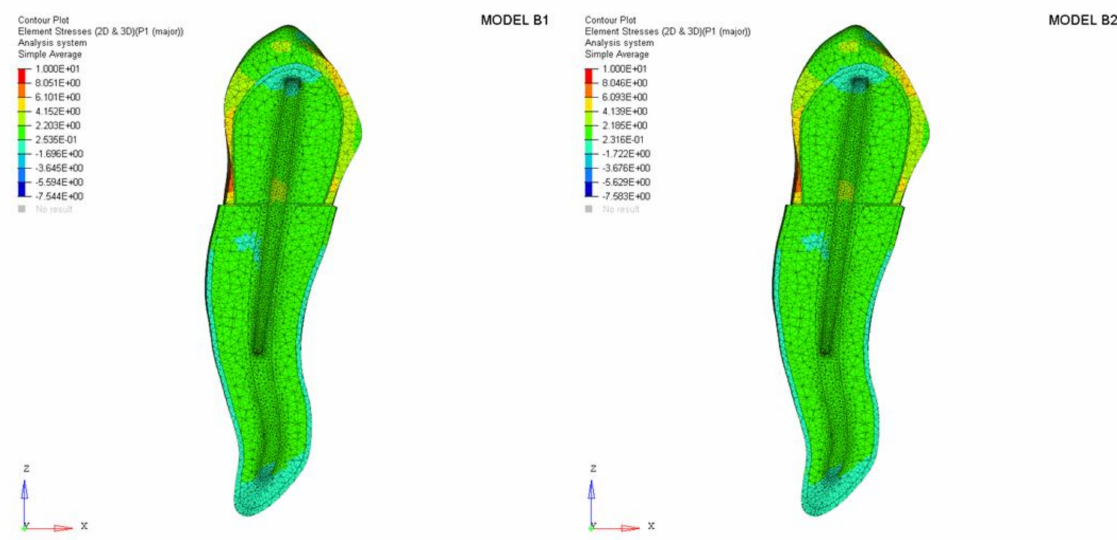
Figure 4. Models B1 and B2: Maximum principal stress distribution (MPa) in the post-restored tooth. The color scale was chosen to allow for comparison among the analyzed